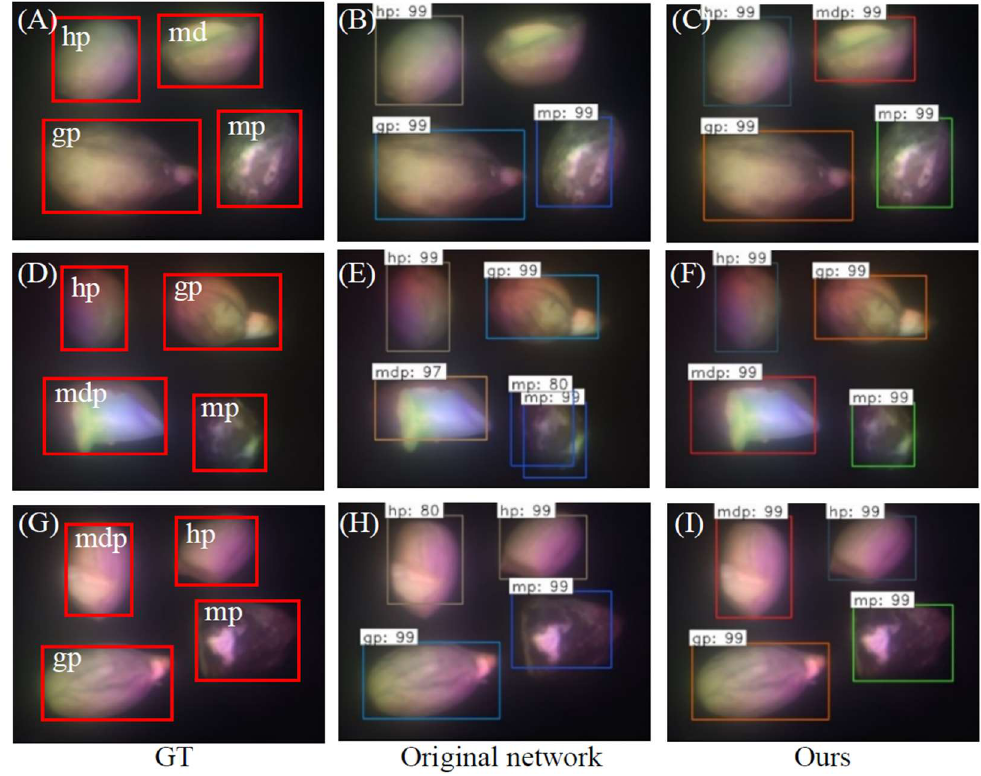
Figure 9. Peanut defect detection results (pictures are pseudo-color image based on CWs: 440 nm , 470 nm , 520 nm ; numbers in the prediction box are confidence scores): (A), (D), and (G) are the labels of manual classification and localization; (B), (E), and (H) are the results of Faster RCNN based on the VGG16 backbone network; (C), (F), and (I) are the results of Faster RCNN improved with TAM and TEM (the rectangular boxes represent the localization information . The text above the boxes indicate the predicted defect types and its confidence level of the algorithm).